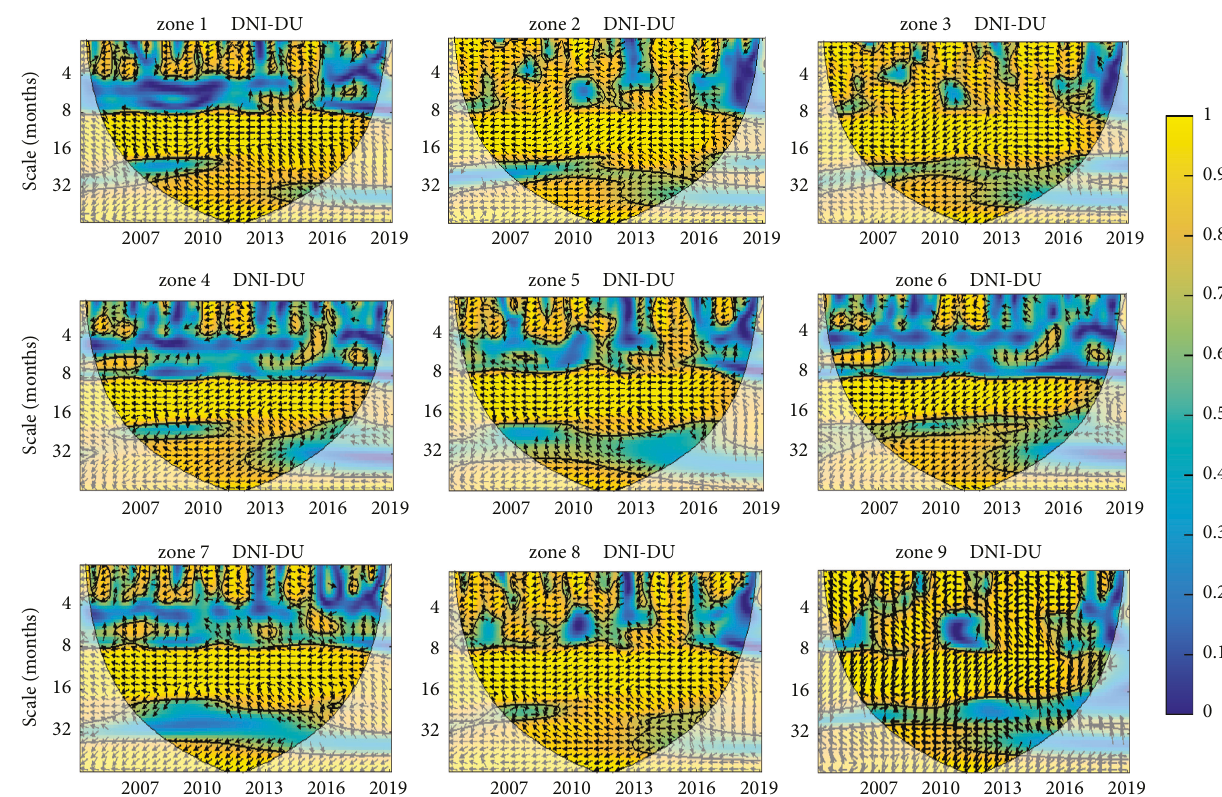
Figure 7: Wavelet coherence between the monthly average of DNI and DU time series (2005–2019). Areas of statistical significance are circled in black; the area outside the cone of influence has no statistical significance. The relative phase dependence is indicated by arrows (antiphase as oriented toward the left, and DNI in advance of phase to DU as arrows pointed downward).